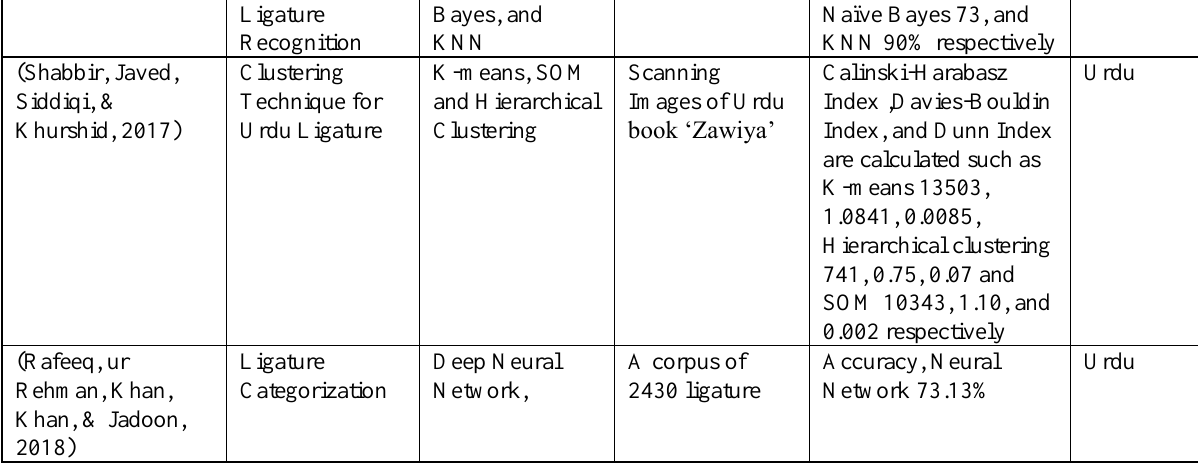
Table 2 Consolidated Statistics of